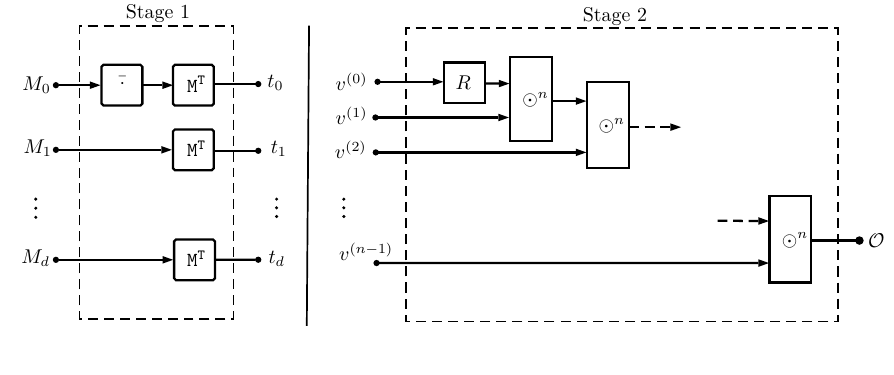
Figure 8: Gadget δ ( ·